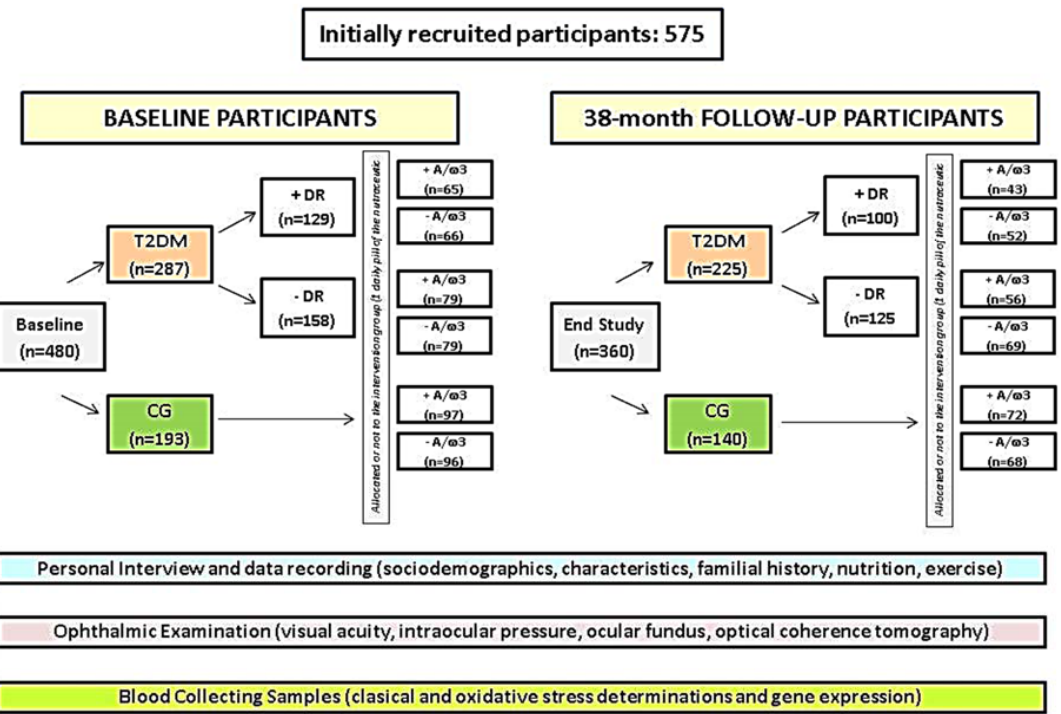
Figure 1. Flowchart of the recruitment, classification, and random assignation of the nutraceutical regimen in the study participants.